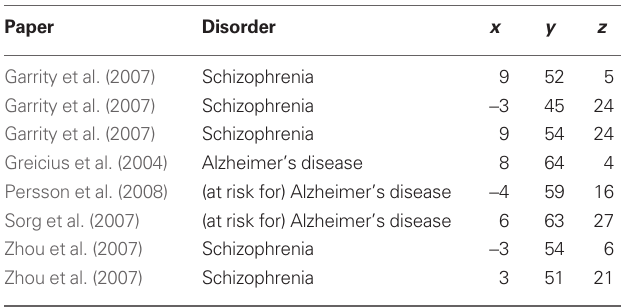
Table 1 | Clinical DMN regions of interest within dorsal medial prefrontal